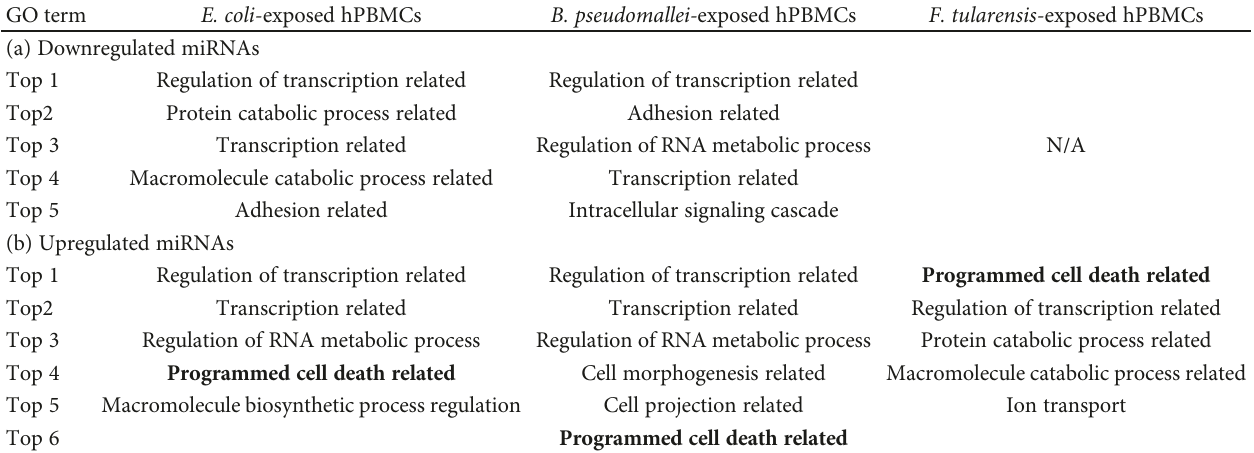
Table 4: GO terms found in the miRNAs di ff erentially expressed in di ff erent organism-exposed samples. GO